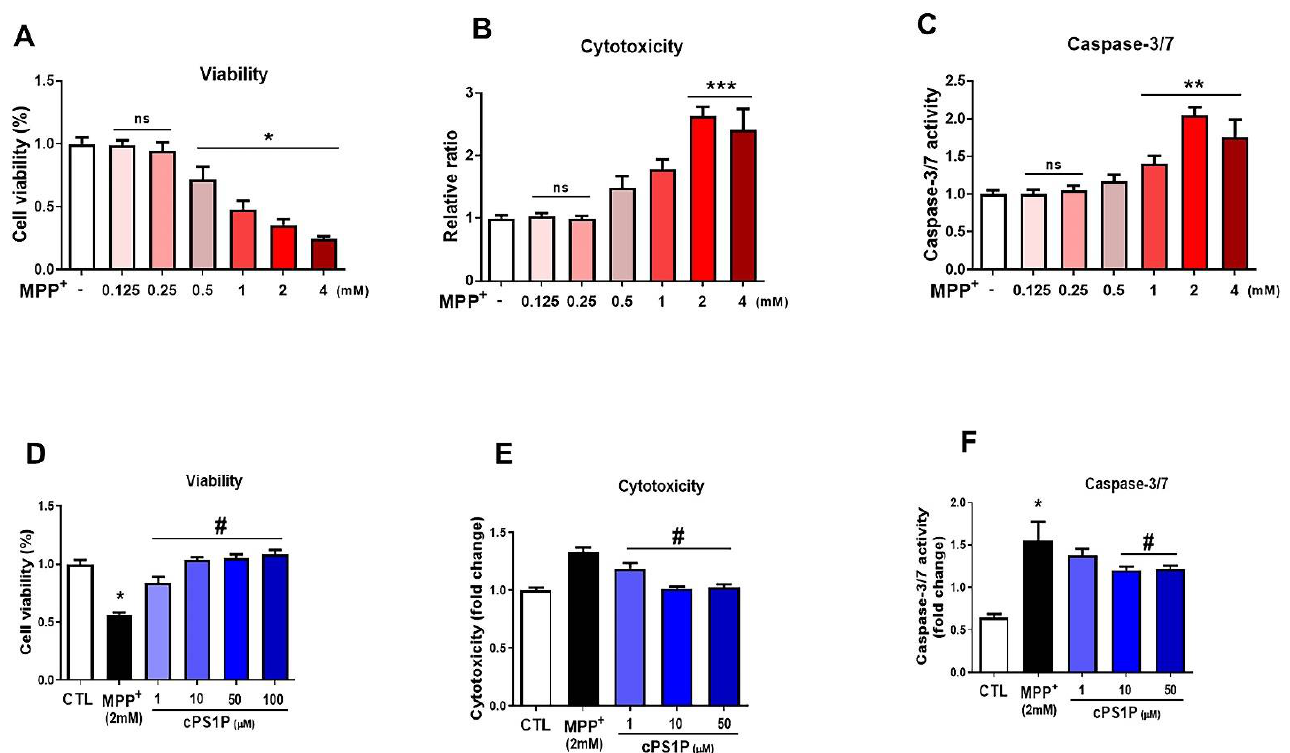
Figure 1. In vitro effects of cPS1P in the SH-SY5Y human neuroblastoma cells. ( A – C ) Cell viability, cytotoxicity, and caspase-3/7, respectively, profiles at different concentrations of MPP+ (n = 3). ( D – F ) Cell viability, cytotoxicity, and caspase-3/7, respectively, of MPP+ (2mM) and cPS1P (1, 10, 50 µM) treatment (n = 3). The values indicate the mean ± SEM. The significant differences have been given in the graphs. * Significant difference between the control and MPP+; # Significant difference between MPP+ and cPS1P treated. p < 0.05 was considered significant difference between the groups. *p < 0.05, **p ≤ 0.01, ***p ≤ 0.001.